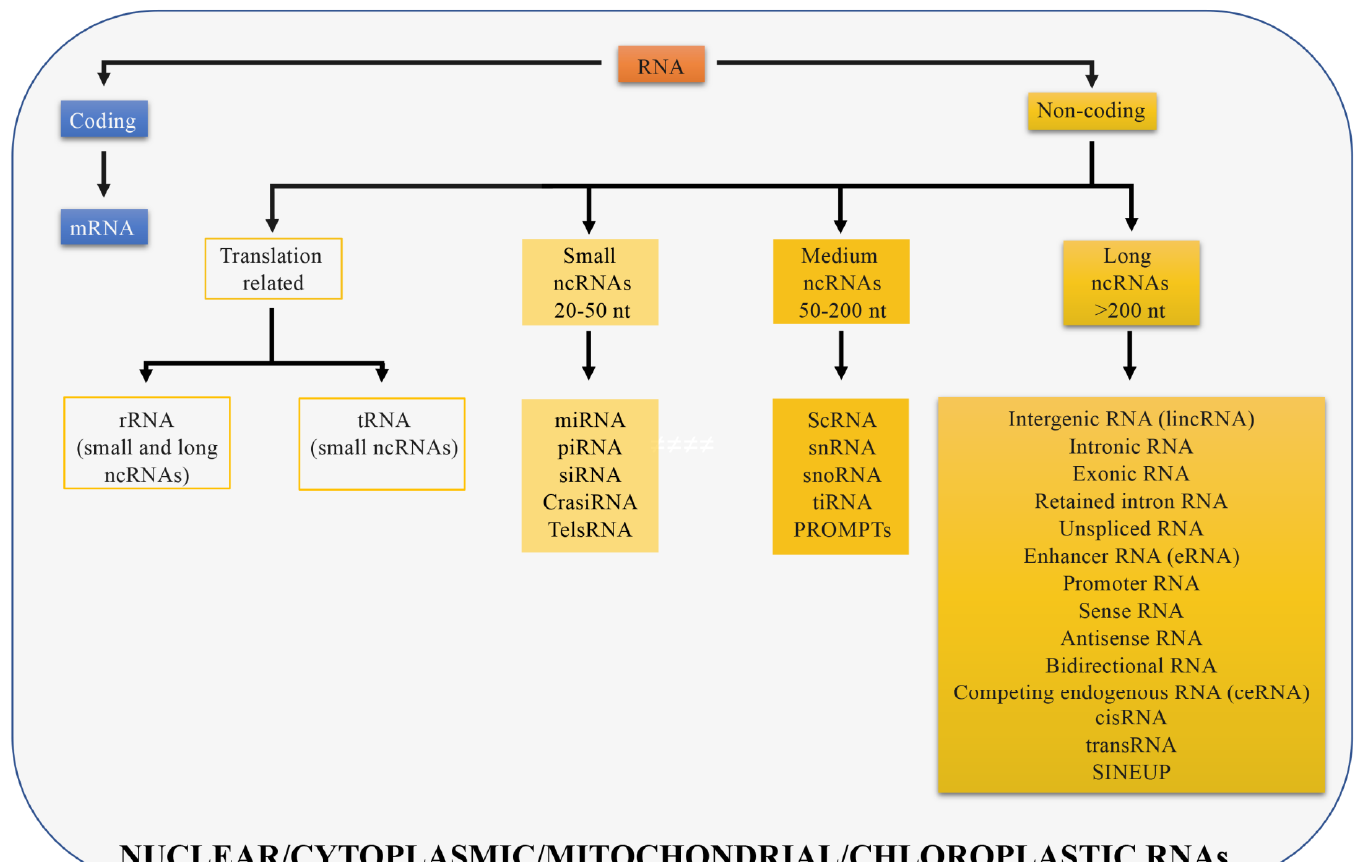
Figure 1. Different RNA types in cells. RNAs are divided in coding (if they are translated; blue) and non-coding (if they are not translated; yellow). Non-coding RNAs can be distinguished in different RNA types depending on their size or function. Long non-coding RNAs are longer than 200 nt and all displayed categories are discussed in the manuscript. Transcripts presented can be localized in the cell nucleus, cytoplasm, or in both compartments, in mitochondria or chloroplasts.